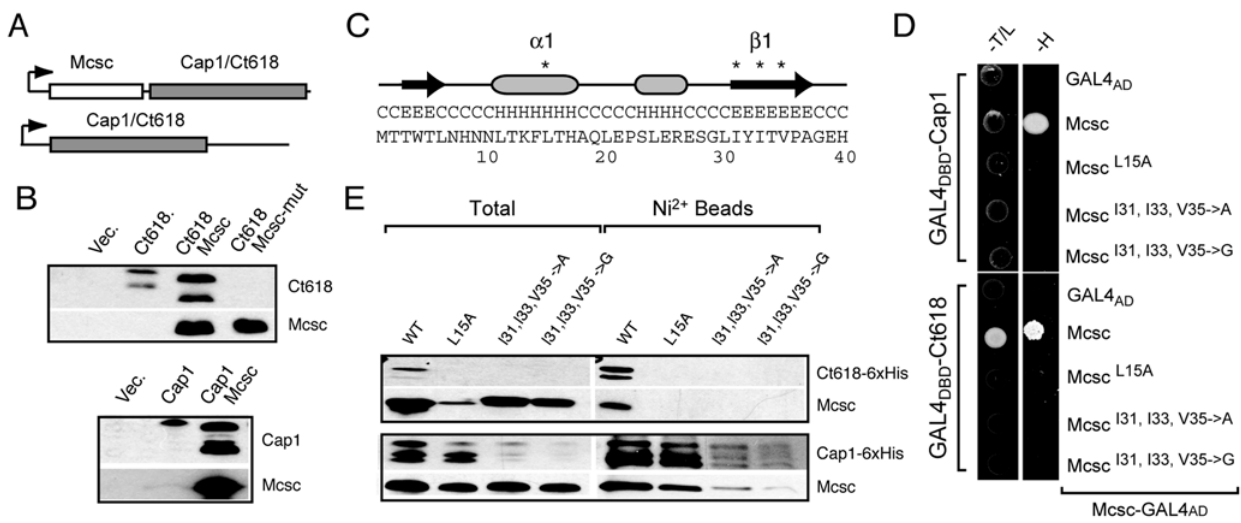
Figure 4. Effector protein stability is linked to Mcsc function. ( A ). Schematic of T7 expression vectors used to test the effect of Mcsc in Ct618 and Cap1 expression ( B ). Ct618 and Cap1 display altered mobility in the presence of Mcsc . Ct618 and Cap1 were expressed with or without Mcsc and total proteins ( , 30 m g) were analyzed by immunoblots with specific antibodies. Note decreased levels of expression and altered sizes of Cap1 and Ct618 in the absence of Mcsc. ( C–E ) Mcsc mutations in the putative effector binding domain disrupt cargo binding and destabilize Cap1 and Ct618 . ( C ). Point mutations in the putative effector binding regions of class I chaperones [44] were generated in the a 1 (L15A) and b 1 strand (L31, L33 & L35 to A or G) either in Y2H ( D ) or in E. coli expression vectors ( E ). ( D ). All Mcsc mutants disrupted the Y2H interactions between Mcsc and Cap1 and Ct618. ( E ). E. coli co-expressing 6xHis-tagged Ct618 or Cap1 with Mcsc mutants were monitored for steady-state expression of recombinant proteins and co- purification on Ni 2 + agarose beads. Mutations in the Mcsc b 1 strand led to substantially lower steady-state levels of Ct618 and Cap1. In contrast, L15A mutants altered Ct618, but not Cap1, stability.